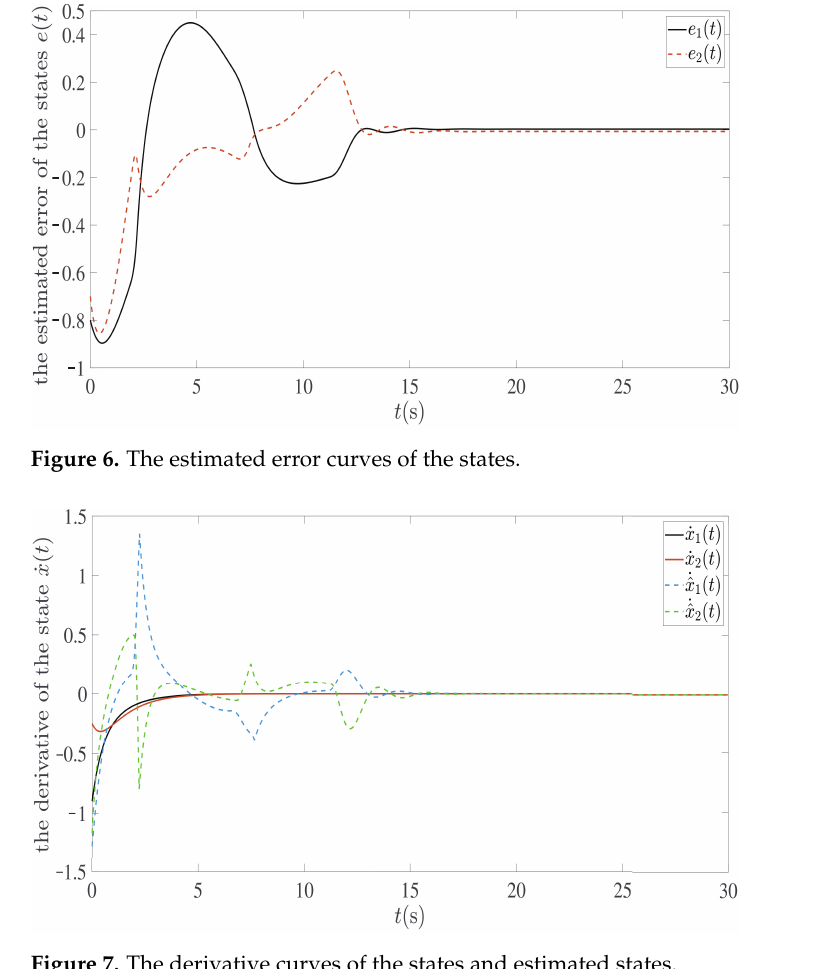
Figure 7. The derivative curves of the states and estimated states.